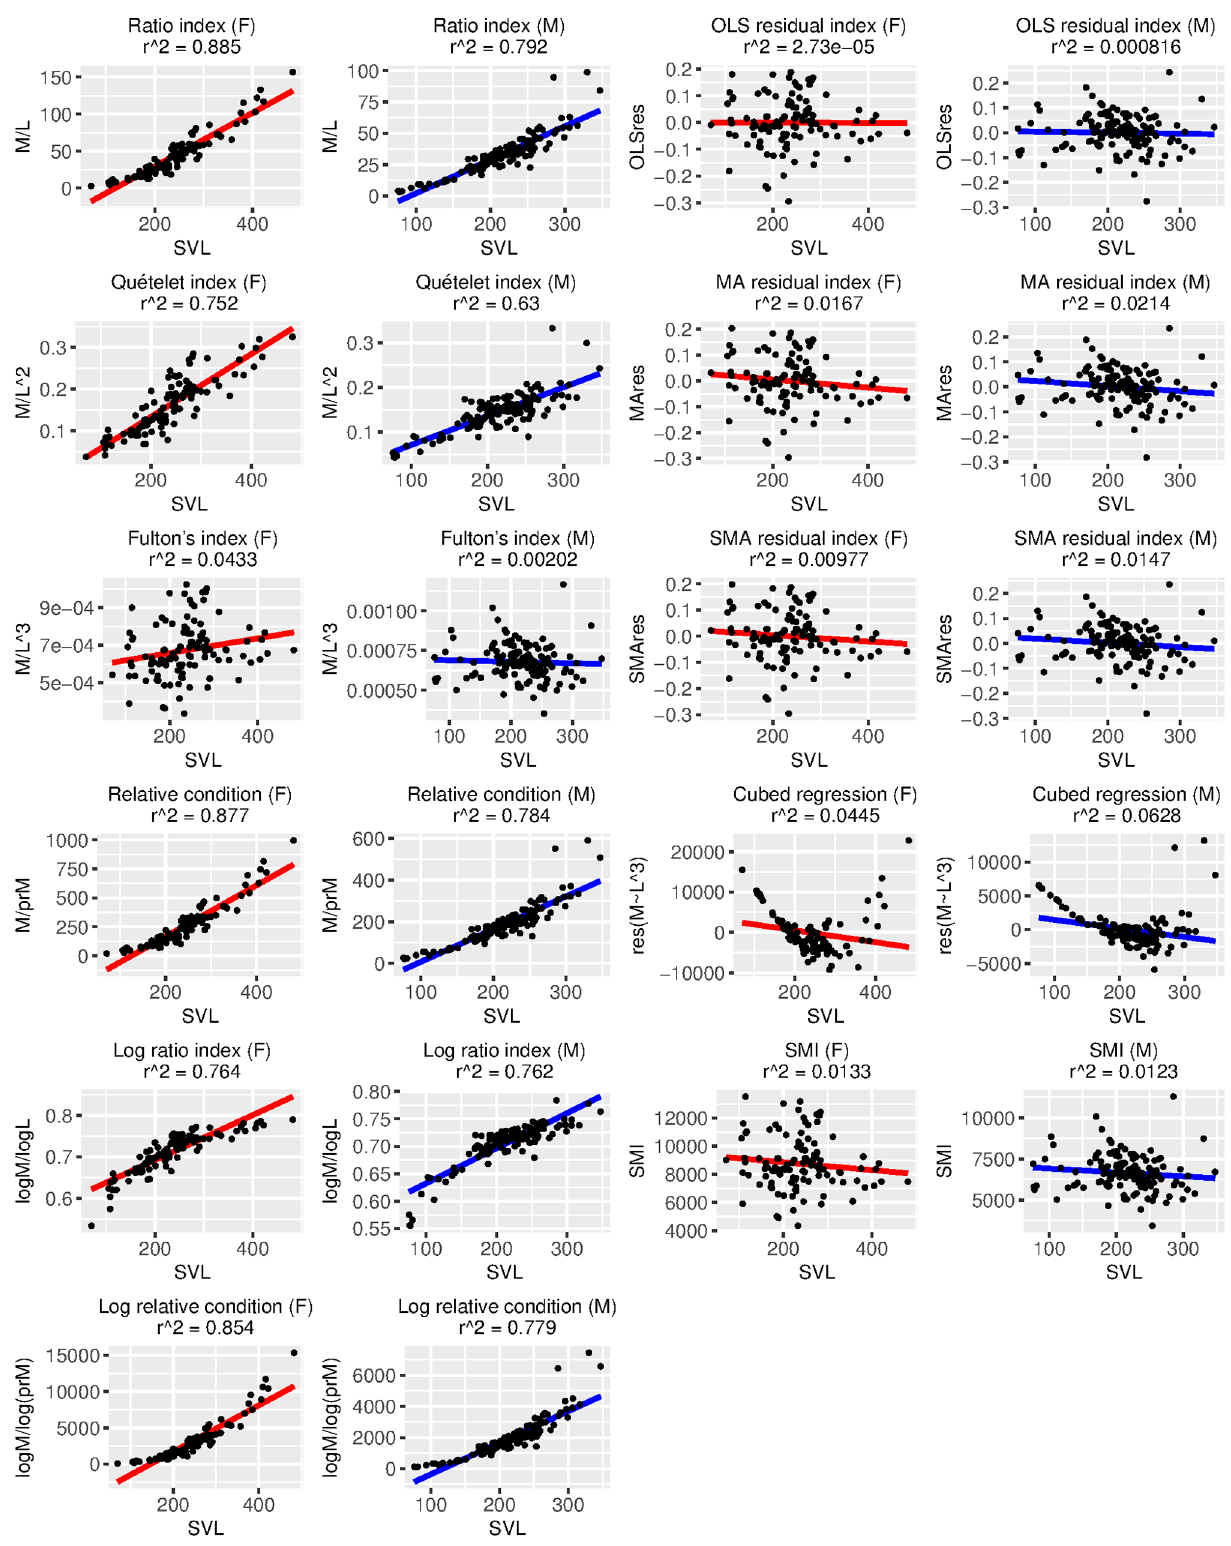
Fig 5. Relationships between 11 body condition indices (BCIs) and snout-vent length (SVL) for each sex. Variationin each BCI that can be explainedby SVL is providedas an r 2 value. An ideal BCI has no relationship (i.e., zero regressionslope and zero r 2 value) with SVL. Descriptions of each BCI are providedin Table